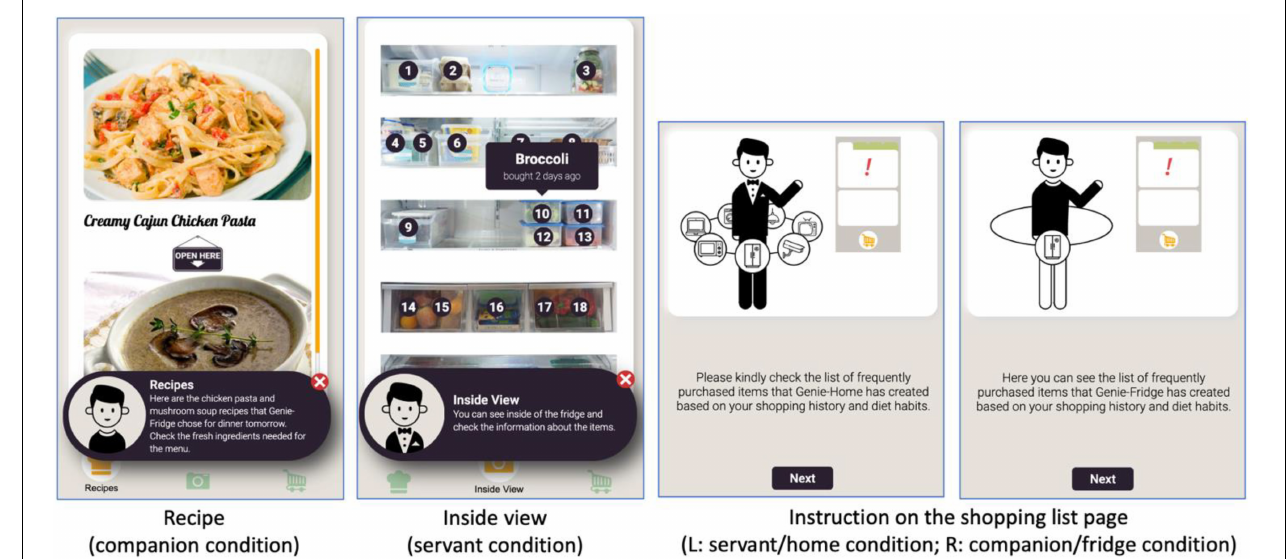
FIGURE 1 | Screenshots of IoT mobile application.